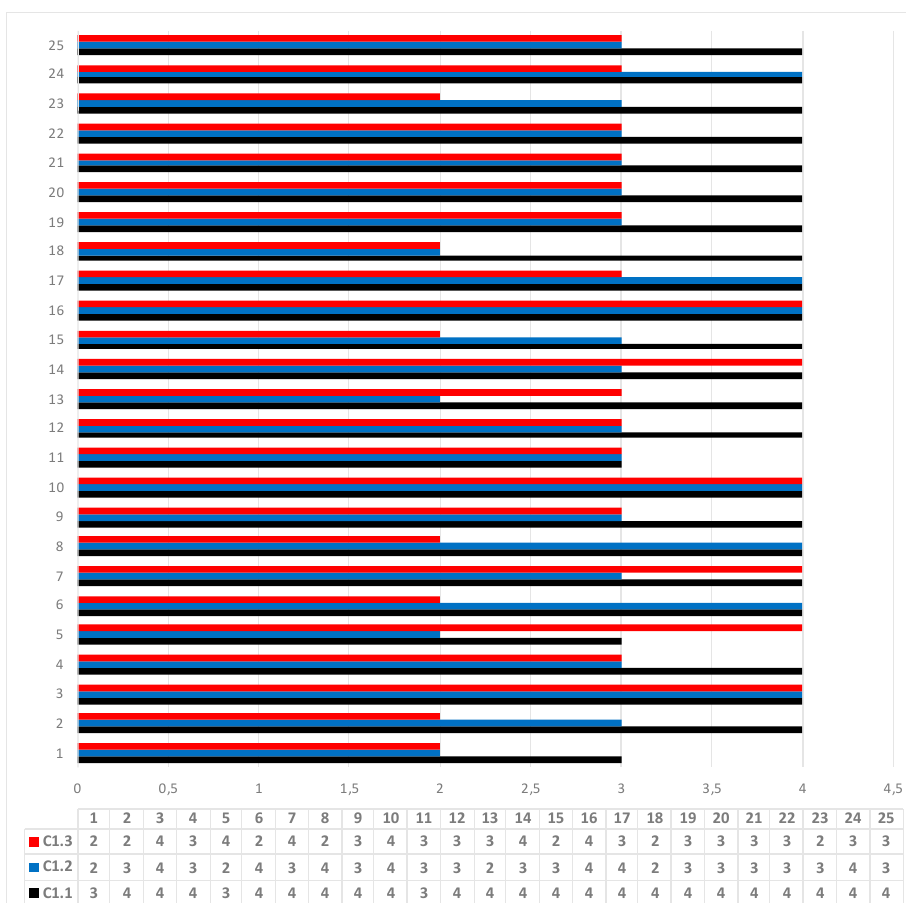
Figure 3. Experts’ opinion concerning the importance of water resources indicators: water resources availability (WRA), annual precipitation (AP) and ratio of treated wastewater (RTW). Table 8. Determination of weights of water resources indicators.